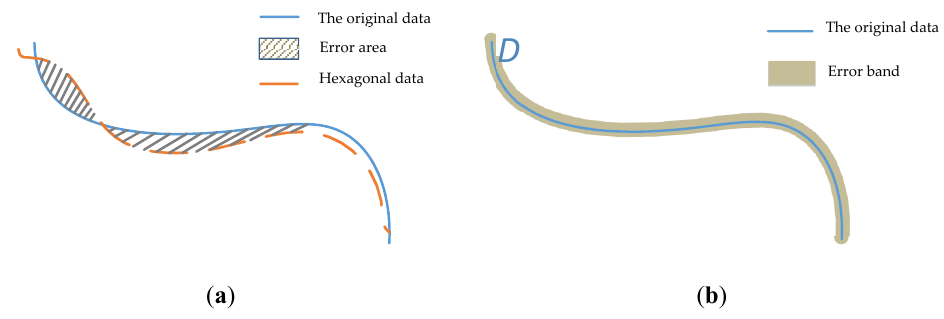
Figure 9. Schematic diagram of error band calculation.